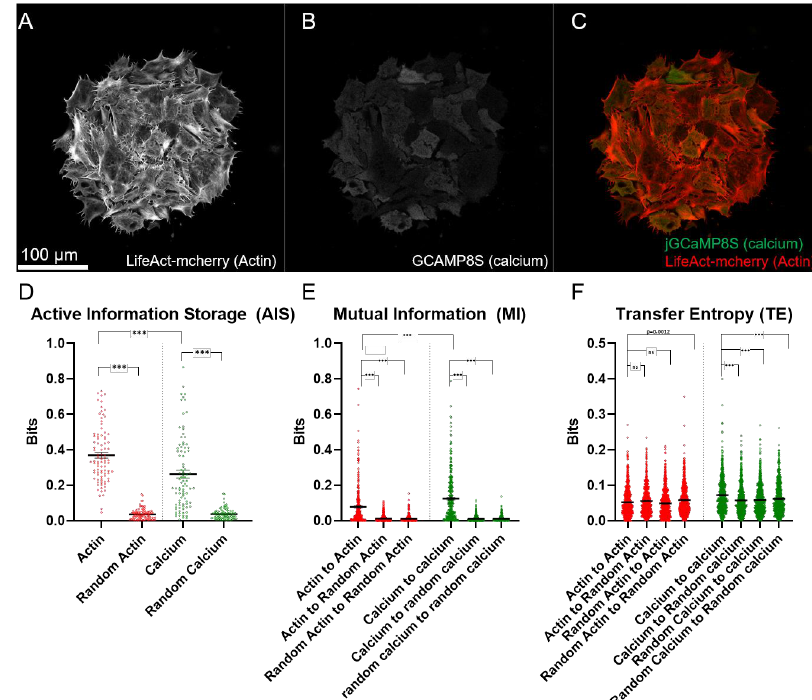
Figure 9. Information metrics within each signal. Representative frame of: ( A ) LifeAct-mcherry; ( B ) jGCaMP8S; ( C ) an overlay of two channels from one of the explants imaged; ( D ) AIS is significantly higher in real vs. randomized datasets for both the actin and calcium signals, and AIS for the actin signal is significantly higher than for the calcium signal; ( E ) mutual information between ROIs within the same time series is higher than for the randomized datasets, and MI is higher between ROIs for the calcium signal than for the actin signal. The calcium signal, but not the actin signal, demonstrates significantly higher TE than any of the randomized datasets ( F ). The real actin signal data demonstrates significantly less TE than the randomized actin does with itself. The real calcium signal also demonstrates significantly greater TE than the actin signal. *** = p > 0.0001, Mann – Whitney test.